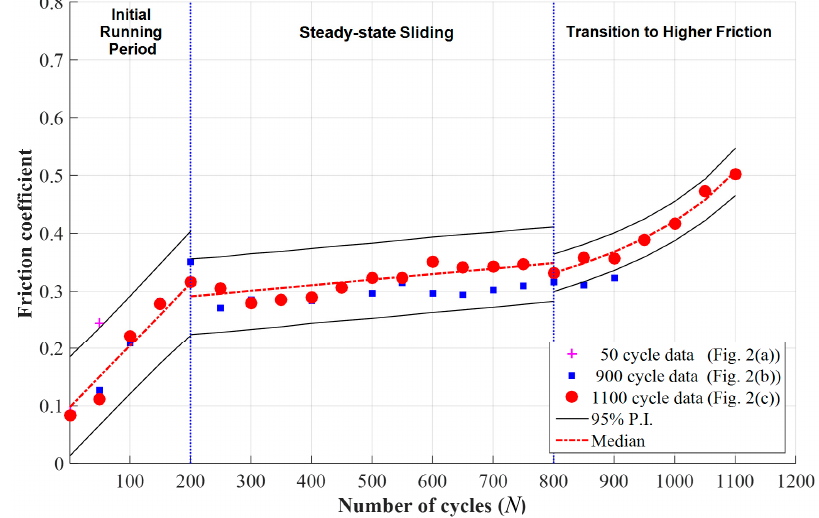
Figure 4. Estimated median and 95% predictive intervals (P.I.) based on the measured data at a normal force of 25 N, a displacement of 1 mm, and a frequency of 1 Hz.